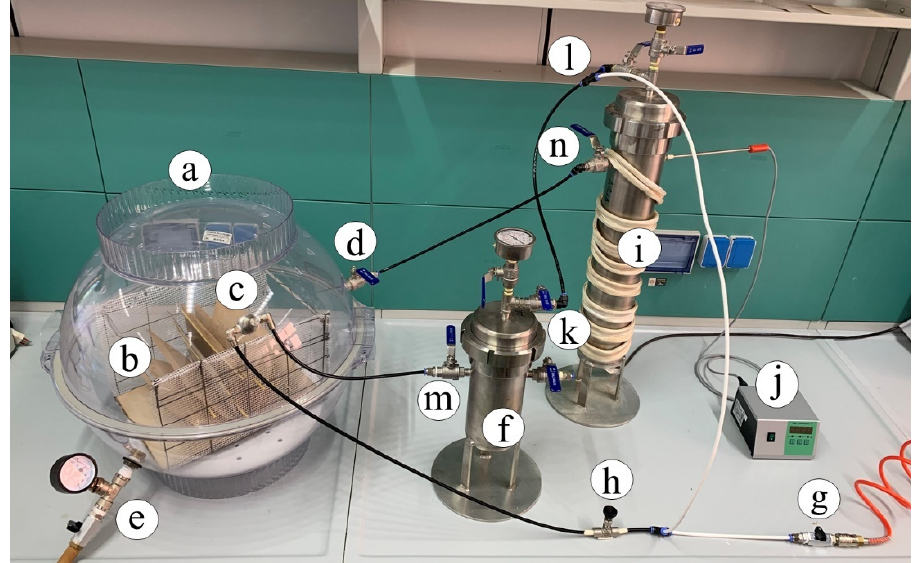
Figure 2. Deacidification homemade apparatus: ( a ) chamber hosting the book during treatment cycles; ( b ) book; ( c ) nuzzle nebulizer; ( d ) valve for dry air inlet; ( e ) valve for the exit of the drying air; ( f ) steel vessel alkaline solution container; ( g ) inlet compressed air; ( h ) T-valve connector; ( i ) steel desiccator; ( j ) temperature control device; ( k – n ) flux control valves.